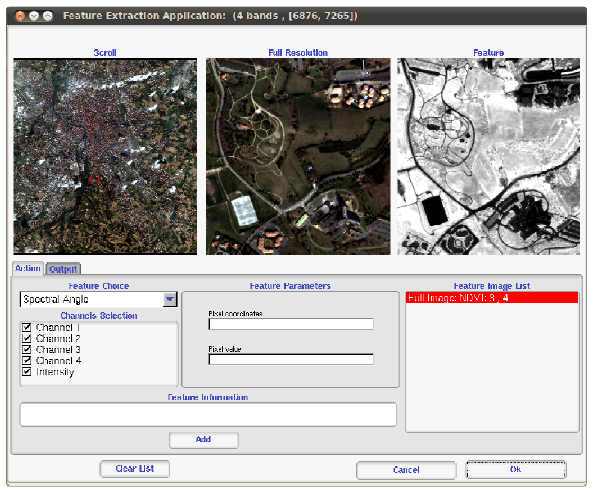
Figure 1. Monteverdi features extraction module 3.2 What